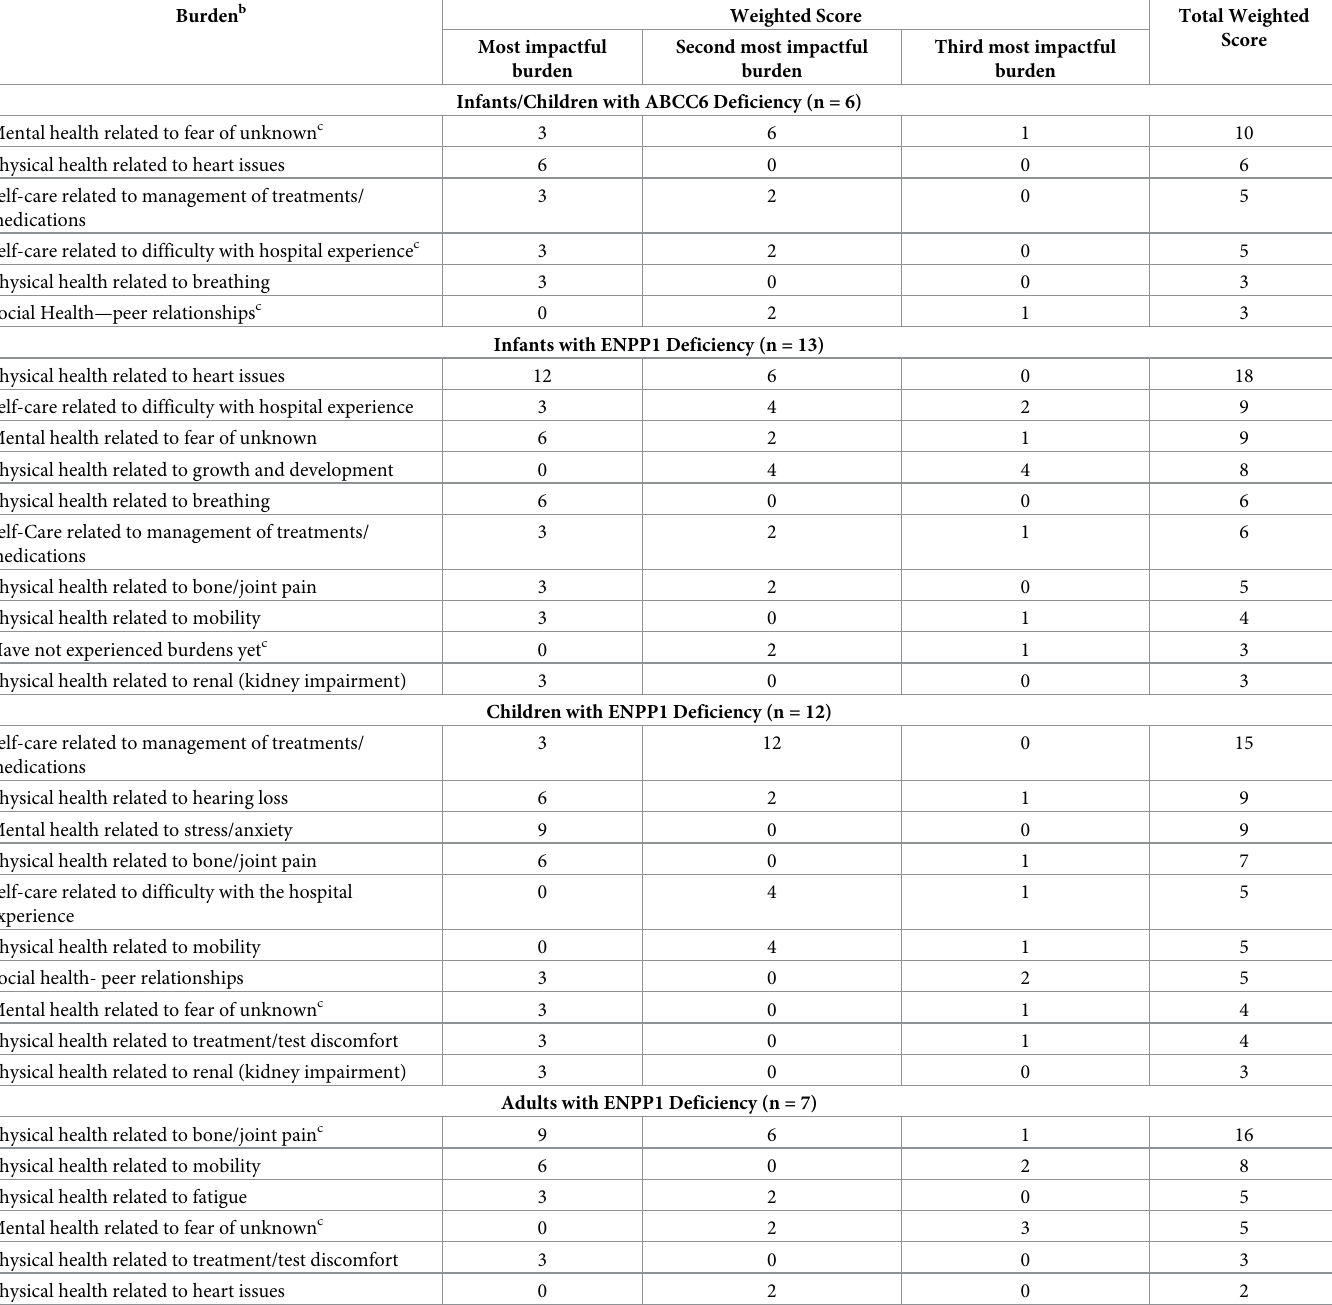
Table 4. Weighted scores of patients or caregiver-reported burden of infant onset ABCC6 Deficiency and ENPP1 Deficiency a